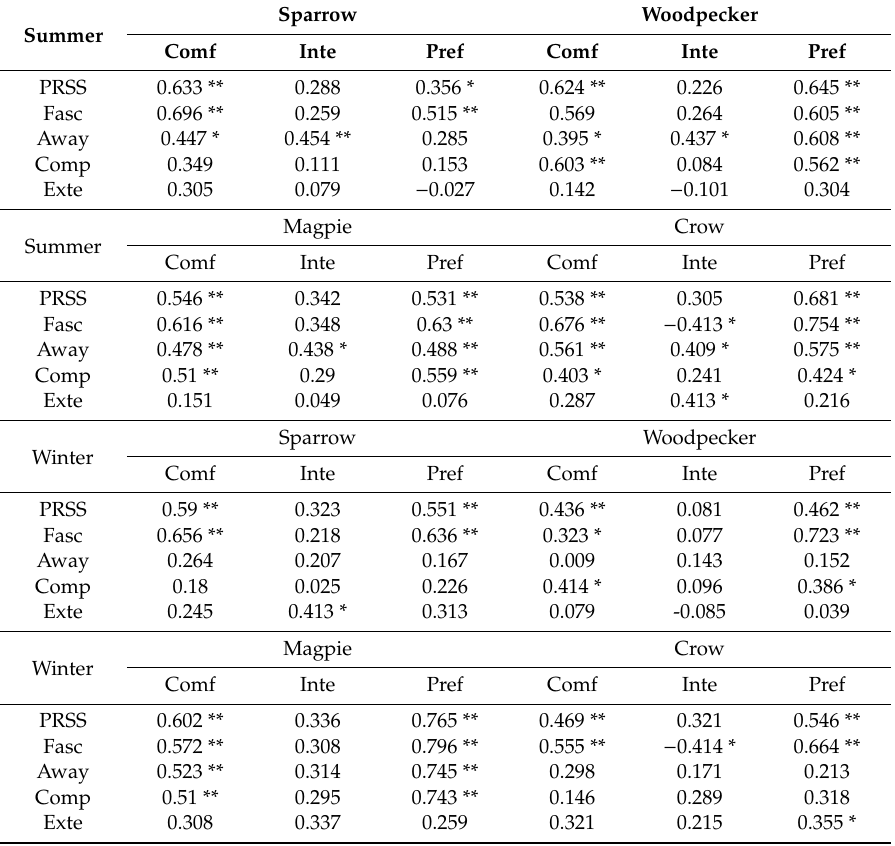
Table 6. Spearman’s Rho correlations between soundscape perception evaluations and the perceived restorativeness soundscape scale (PRSS) for di ff erent birdsongs. Fasc = fascination; Away = being away; Comp = compatibility; Exte = extent; Comf = sound comfort; Inte = perceived intensity; and Pref =